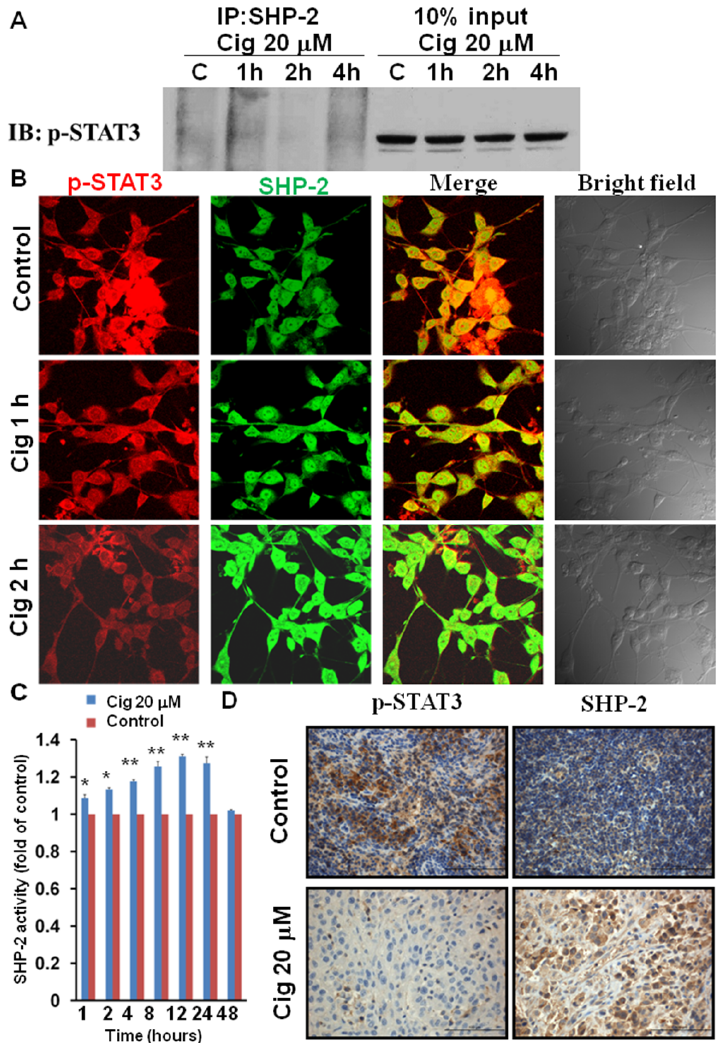
Figure 5. Interaction between phospho-STAT3 and SHP-2 activity by ciglitazone in vitro and vivo study. U87 cells were treated with ciglitazone and the whole cell lysates immunoprecipitated with SHP-2 and immunoblot with phospho-STAT3 (Tyr 705). U87 were treated with vehicle or ciglitazone 20 µ M for 1 h and whole cell lysates for SHP-2 activity. Immunohistochemistry staining was used to assess U87 cells and subcutaneous glioma tissue to measure the phospho-STAT3 (Tyr 705) and SHP-2 expression. ( A ) U87 cells were treated with ciglitazone in a time-dependent course and the whole cell lysates immunoprecipitated with SHP-2 and immunoblotted with phospho-STAT3 (Tyr 705). ( B ) Immunocytochemical analysis of SHP-2 (green) and phospho-STAT3 (Tyr 705) (red) proteins was shown under 400 × magnification. Colocalization of two proteins was shown as merged image. ( C ) U87 were treated with vehicle or ciglitazone 20 µ M for 1 h and whole cell lysates for SHP-2 activity assay determined at the different time profile with three repeated